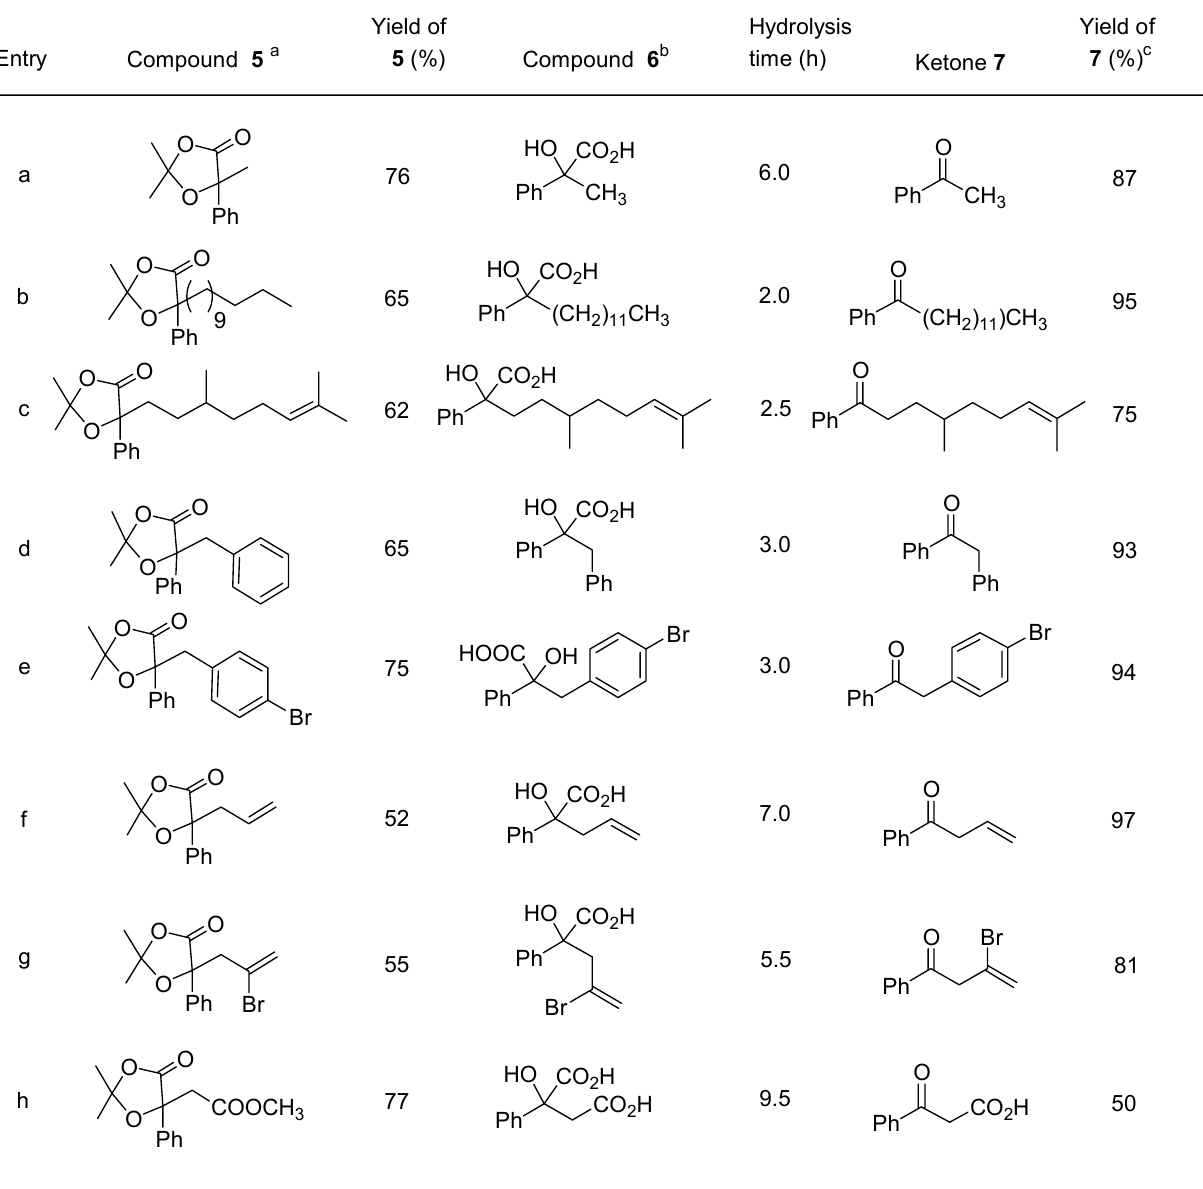
Table 1. Alkylation of 2,2-dimethyl-5-phenyl-1,3-dioxolan-4-one ( 3 ) and